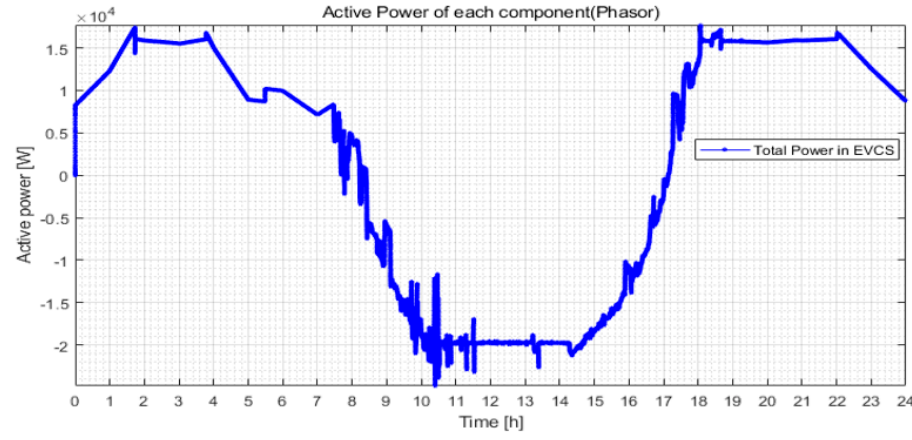
Figure 16. Analysis (power) of hosting capacity characteristic at EVC infrastructure with ESS.